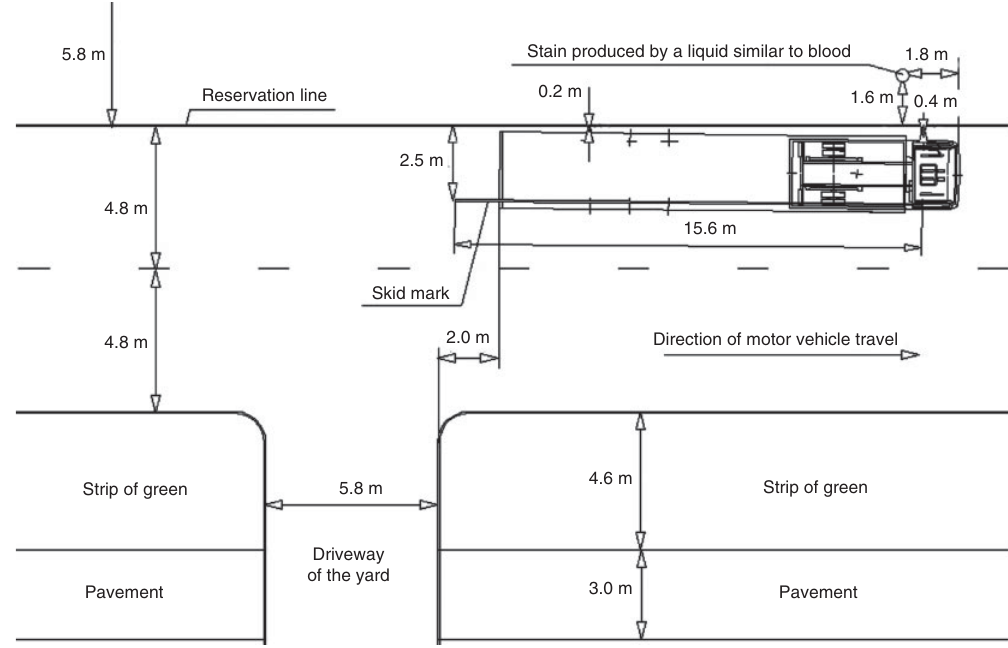
Fig. 8. The diagram of the traffic accident